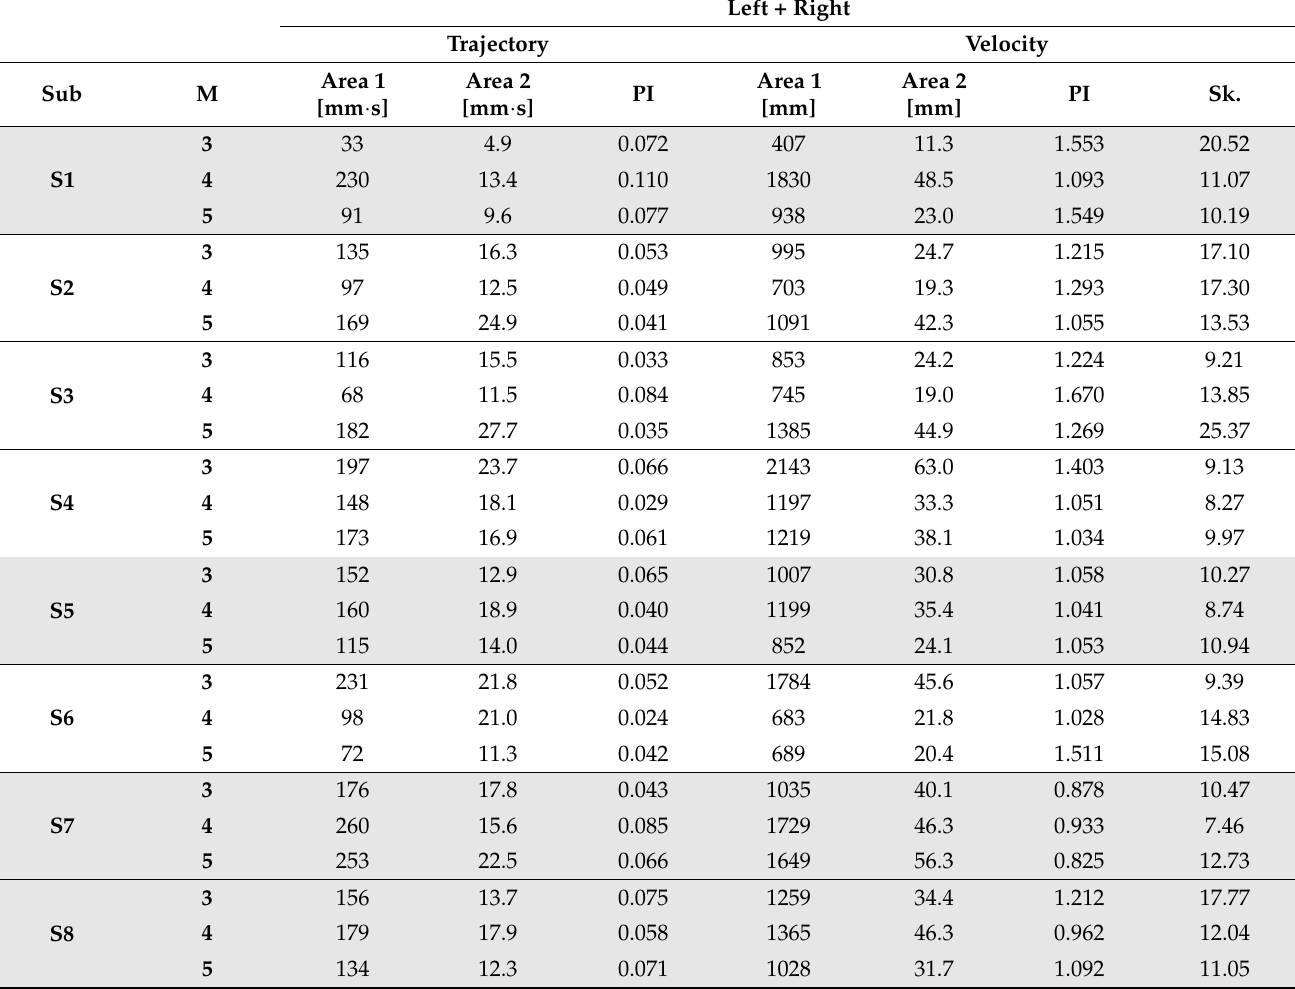
Table A2. Relevant values of parameters of “Left + Right sides” described in Figure 4 obtained from wrist trajectories and velocities for each infant at each timepoint (3, 4 and 5 months). “M” is month, “Area 1” is “Area differing from moving average”, “Area 2” is “Area out of standard deviation of moving average”, “PI” is “Periodicity Index” and “Sk.” is “Skewness”. “Area 1” was normalized by the length of the moving average window (2 s) while “Area 2” was normalized by the samples in which the signal was outside the standard deviation. Subjects not suggesting a non- normal development are